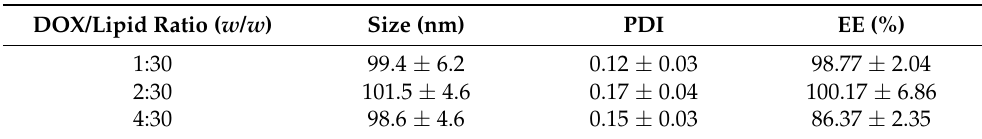
Table 1. Effects of DOX with different concentrations on particle size, potential and entrapment efficiency of liposomes of Dios-DOX-liposomes. DOX/Lipid Ratio ( w / w